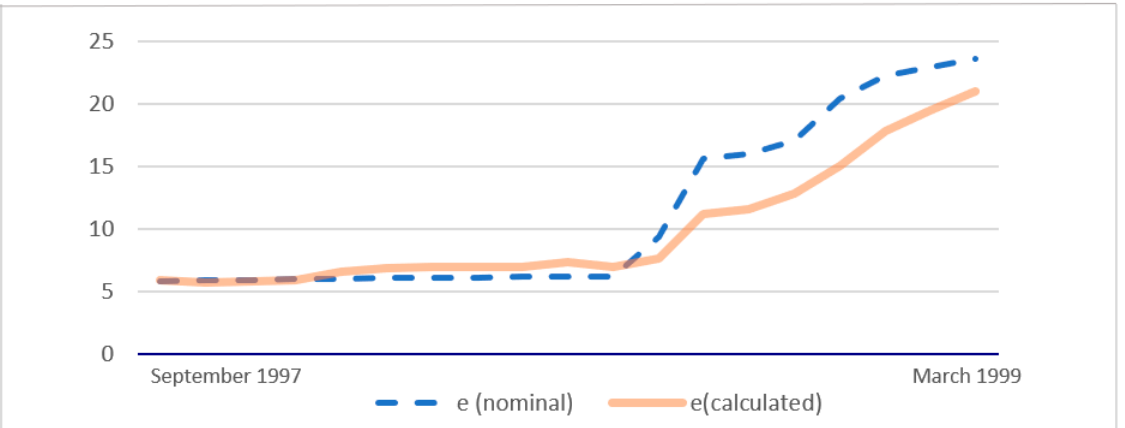
Figure 1. Calculated and nominal USD/RUR exchange rates (August 1997–March 1999, author’s cal- culations, monthly data). calculations, monthly